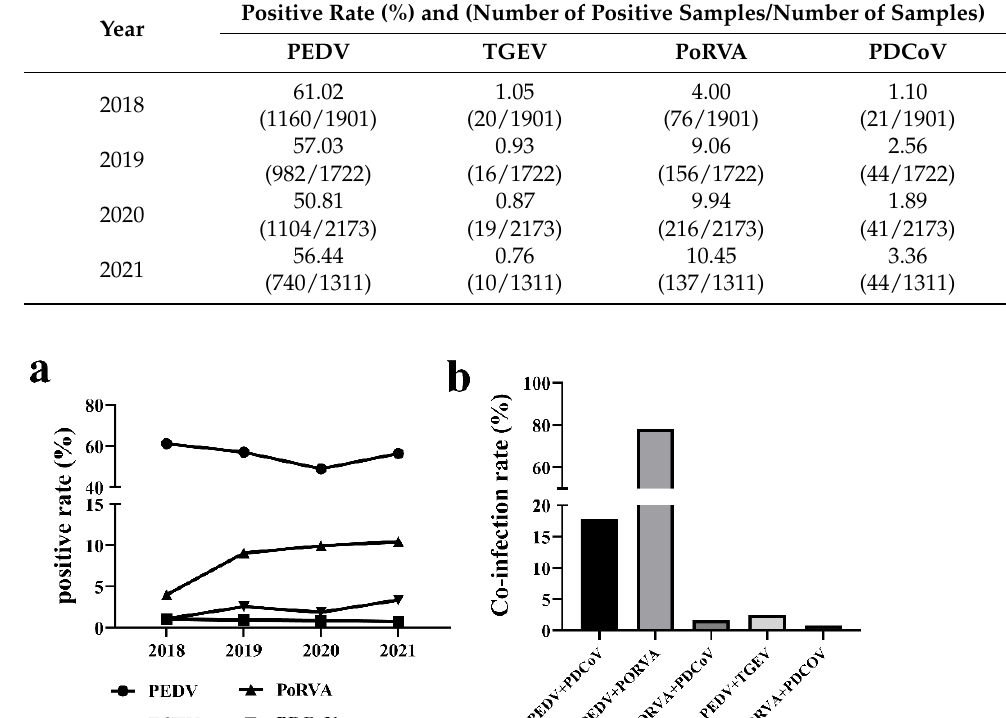
Table 4. Positive rates of swine enteric virus from 2018 to 2021.